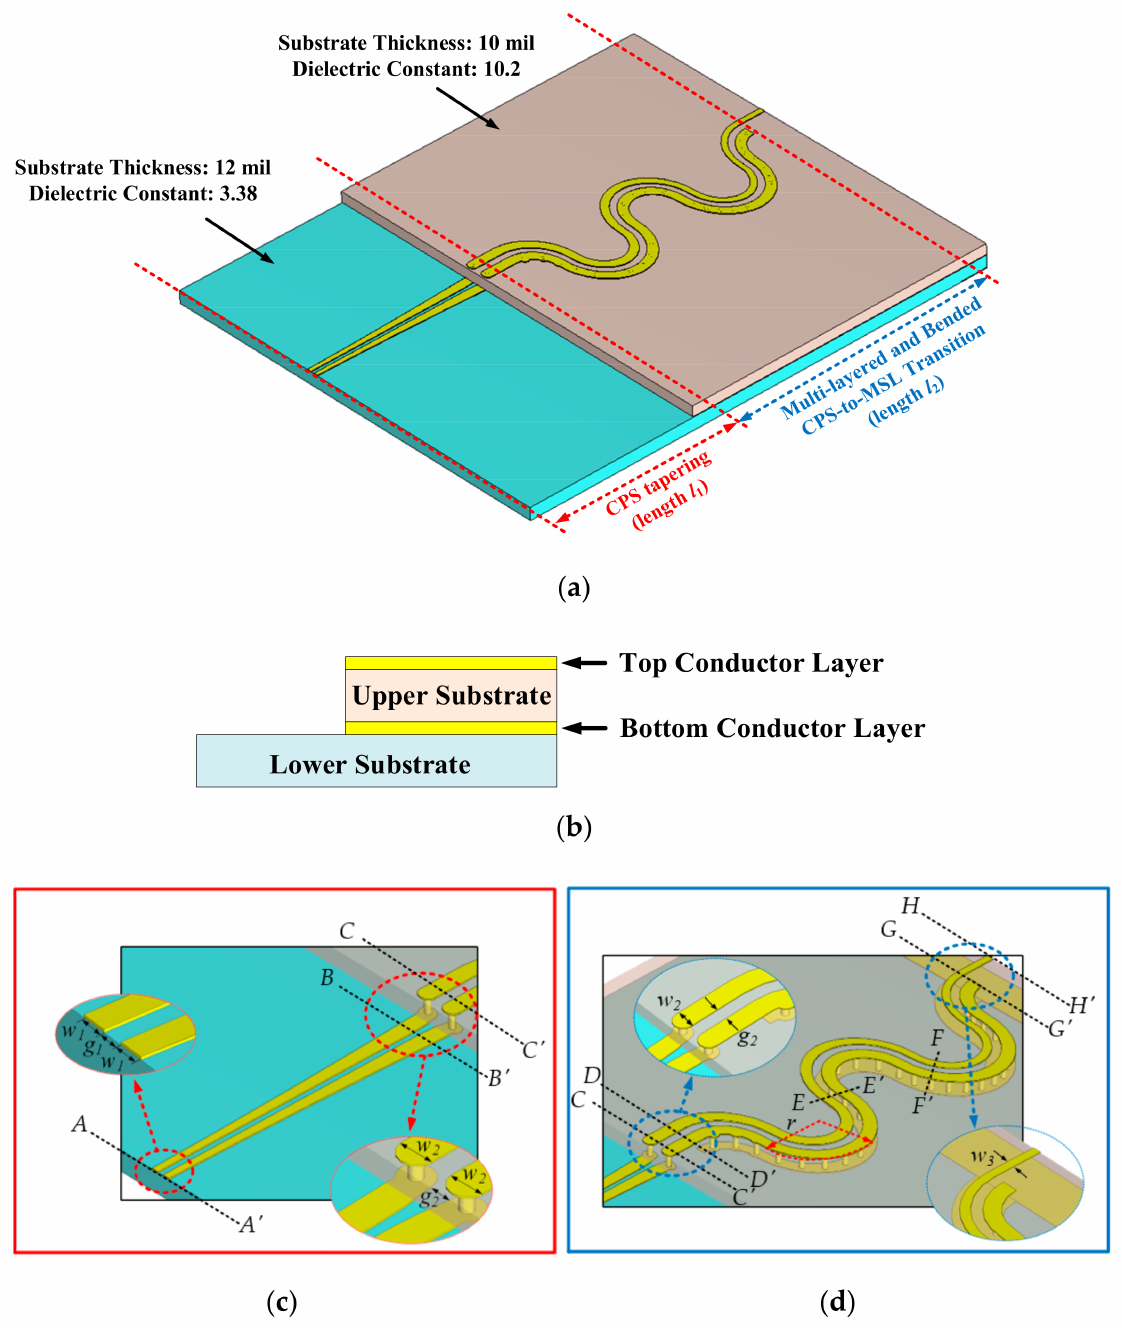
Figure 2. Configuration of the proposed compact CPS-to-MSL transition: ( a ) perspective view, ( b ) side view, ( c ) CPS taper, ( d ) bended CPS-to-MSL transition on a two-layered